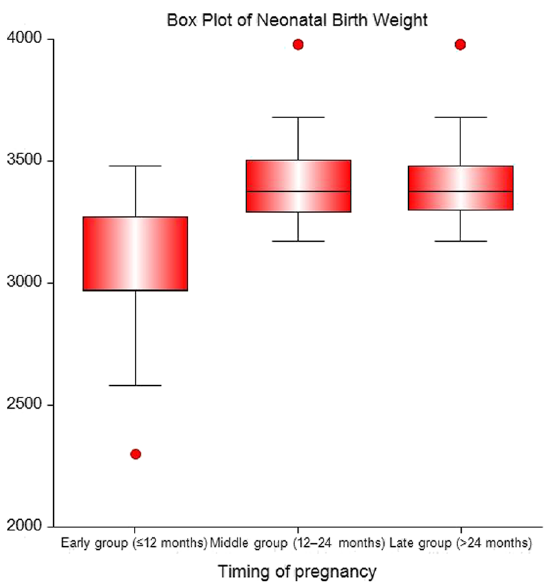
Fig. 2 Box‑Plot of neonatal birth weight in the three